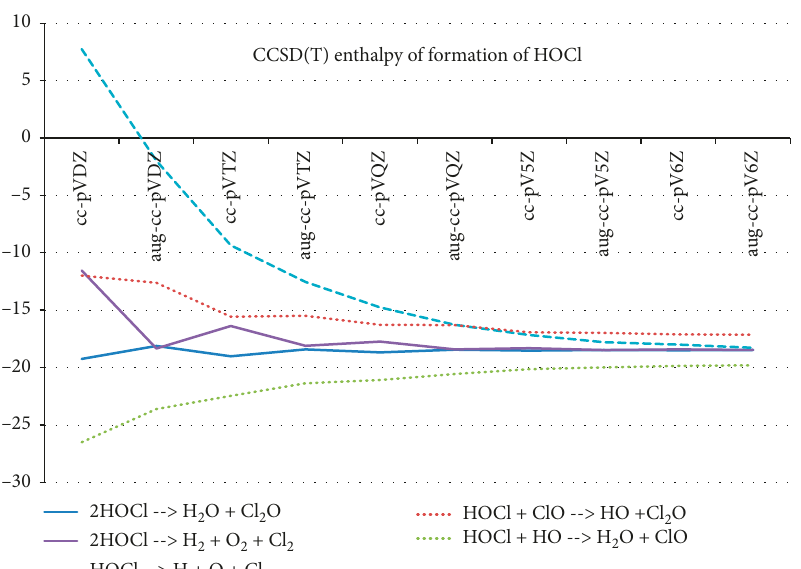
Figure 5: Enthalpies of formation of HOCl (in kcal/mol) obtained at the CCSD(T) level using different basis sets and reactions